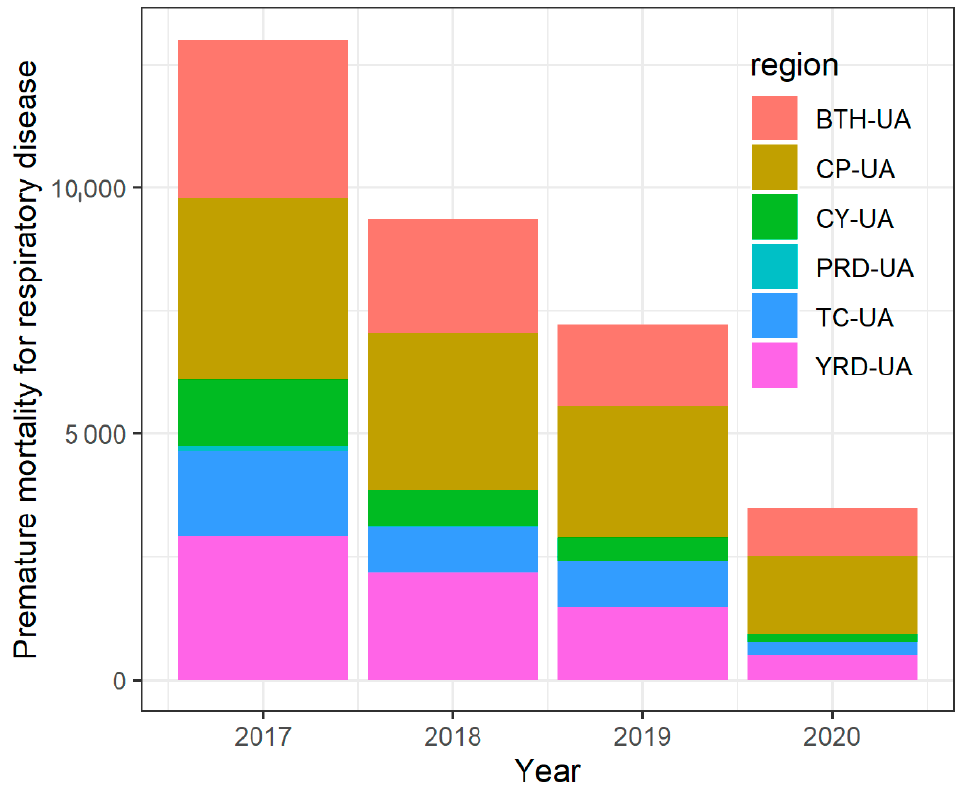
Figure 10. Bar chart of premature mortality for respiratory disease attributed to PM 2.5 exposure in six urban agglomerations, from 2017 to